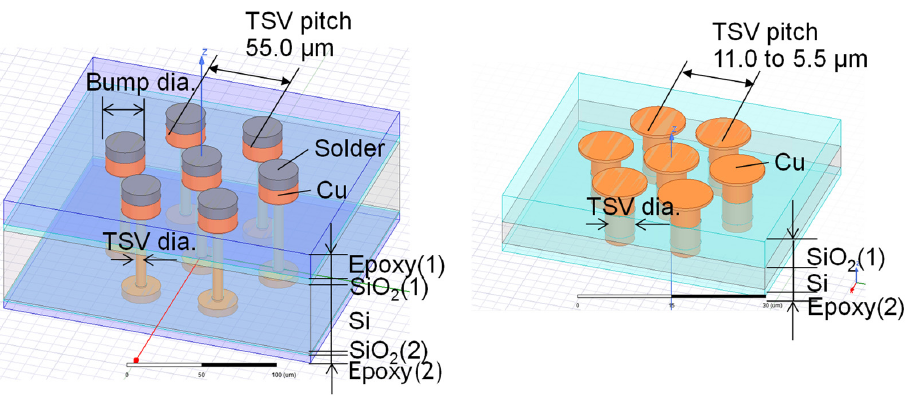
Figure 30. TSV model for 3D EM field analysis; ( a ) 3DI with micro-bumps and ( b ) BBCube. Table 2. Physical dimension.